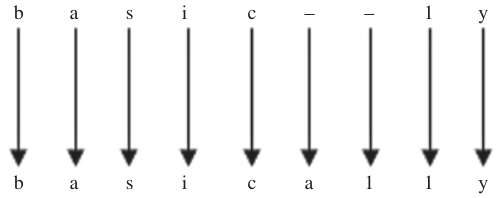
Figure 1: Edit-Based Sequence